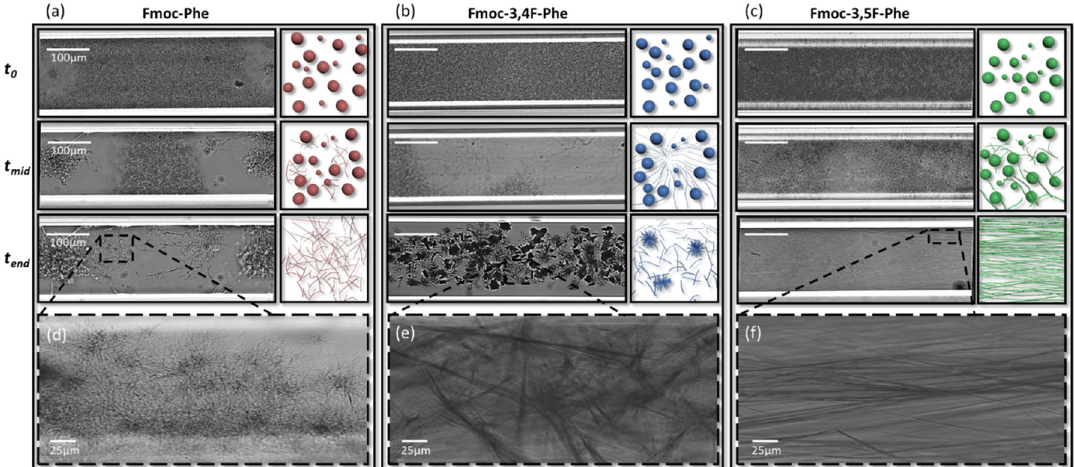
Figure 4. Real-time monitoring of the phase transition over time, and a schematic illustration of the different structures. Phase transition at three different time points; ( t 0 ) spherical structures, ( t mid ) the spheres disassembly slowly and are replaced by a fibrillary gel, ( t end ) final morphology of each building block ( a ) Fmoc-Phe ( b ) Fmoc-3,4F-Phe ( c ) Fmoc-3,5F-Phe. The final stage is shown at a magnified scale to enable visualization of the differences in morphology for ( d ) Fmoc-Phe ( e ) Fmoc-3,4F-Phe ( f ) Fmoc-3,5F-Phe.